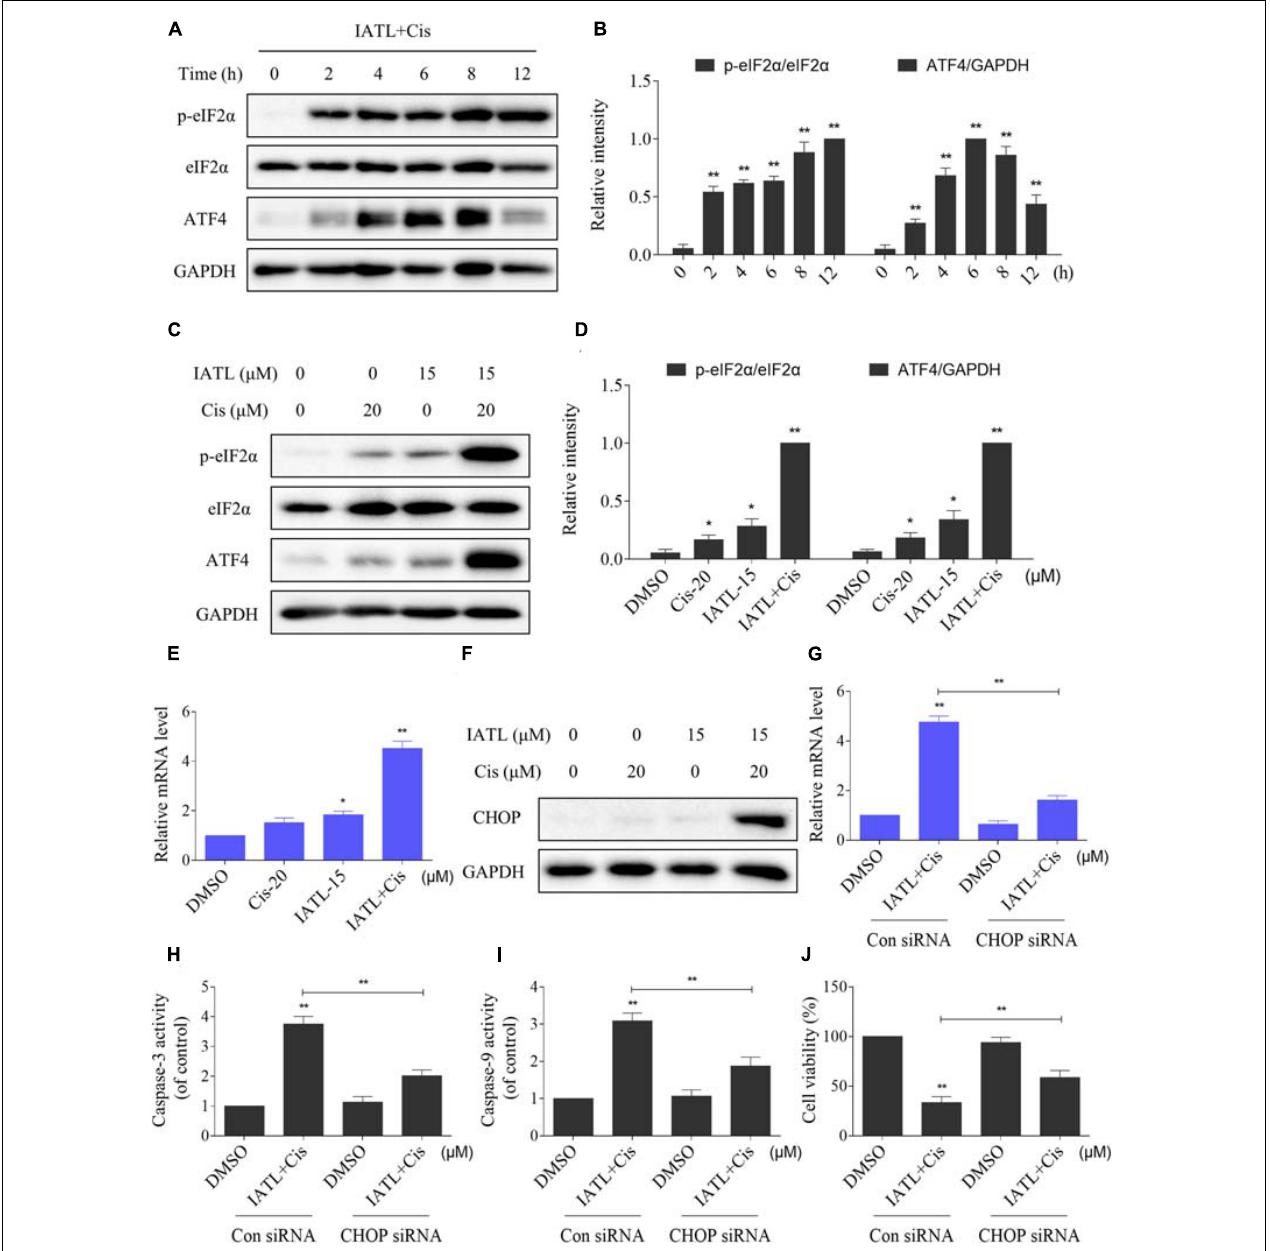
FIGURE 3 | IATL and cisplatin co-operate to activate ER stress in prostate cancer cells. (A,B) DU145 cells were treated with IATL (15 µ M) and cisplatin (20 µ M) combination for the indicated time periods; the expression of p-eIF2 α and ATF4 was measured by Western blot. (C,D) DU145 cells were treated with IATL (15 µ M) or cisplatin (20 µ M) alone or their combination (15 µ M IATL and 20 µ M cisplatin); the expression of p-eIF2 α and ATF4 was measured by Western blot. (E) DU145 cells were treated with IATL (15 µ M) or cisplatin (20 µ M) alone or their combination (15 µ M IATL and 20 µ M cisplatin) for 6 h; the mRNA level of CHOP was determined by qRT-PCR. (F) DU145 cells were treated with IATL (15 µ M) or cisplatin (20 µ M) alone or their combination (15 µ M IATL and 20 µ M cisplatin) for 12 h; the expression of CHOP was measured by Western blot. (G) DU145 cells were infected with CHOP siRNA; the mRNA level of CHOP was determined by qRT-PCR after being treated with the combination of IATL (15 µ M) and cisplatin (20 µ M) for 6 h. (H,I) DU145 cells transfected with CHOP siRNA were treated with the combination of IATL (15 µ M) and cisplatin (20 µ M) for 20 h; caspase-3 and caspase-9 activity was measured by an assay kit. (J) DU145 cells transfected with CHOP siRNA were treated with the combination of IATL (15 µ M) and cisplatin (20 µ M) for 24 h; cell viability was measured by an MTT assay. * p < 0.05, ** p < 0.01.